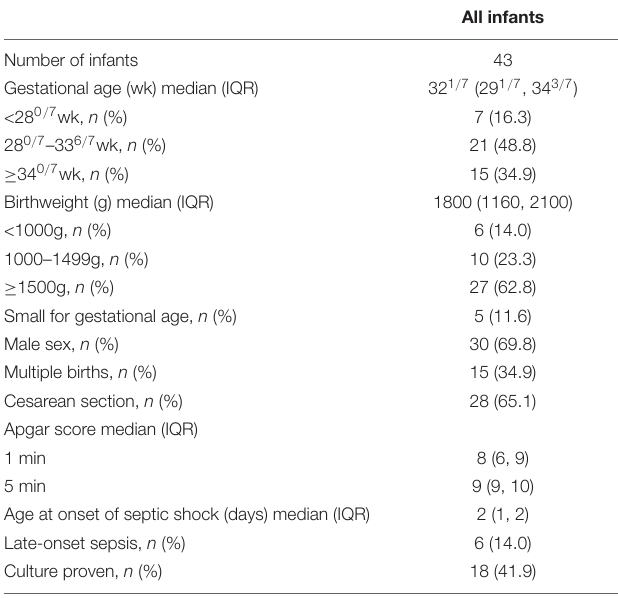
TABLE 1 | Demographic data in the studies